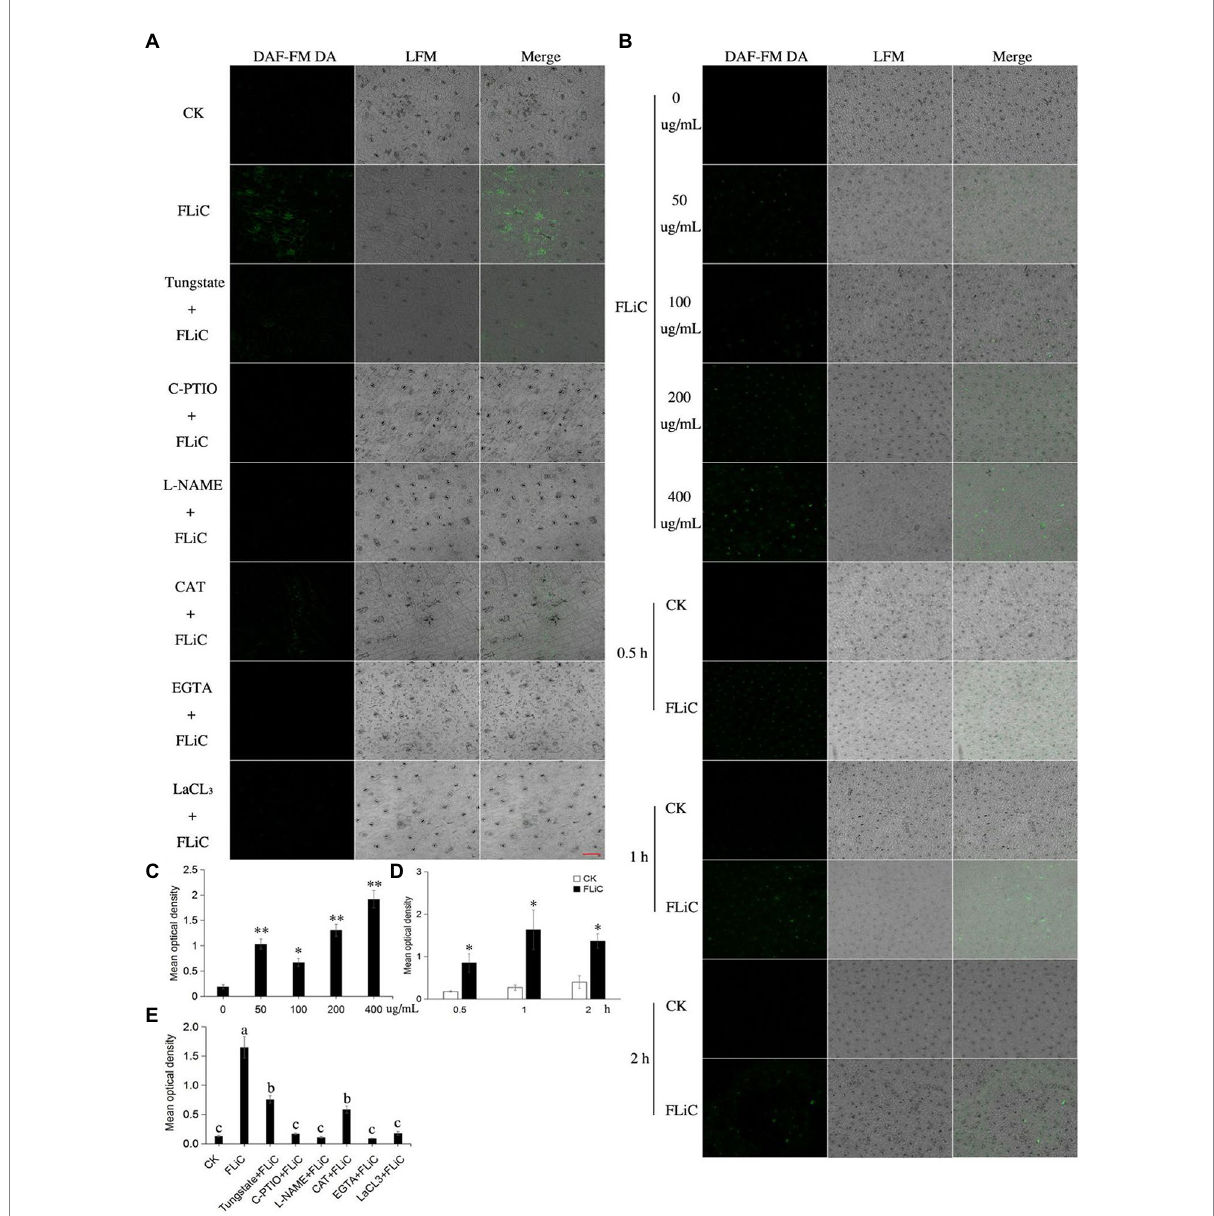
FIGURE 5 NO production in upland cotton leaves in response to FLiC treatment. (A) Fluorescence of upland cotton epidermal cells in response to different treatments